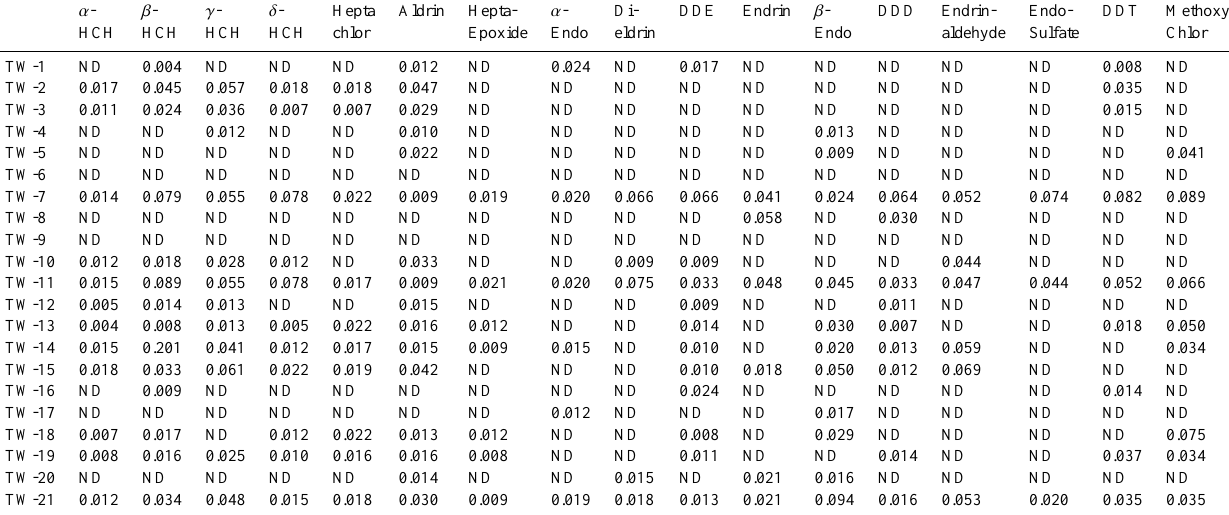
Table 5. Organochlorine residues ( µ gl − 1 ) in ground water (bore well) of Palla area during pre-monsoon seasons. α - β -